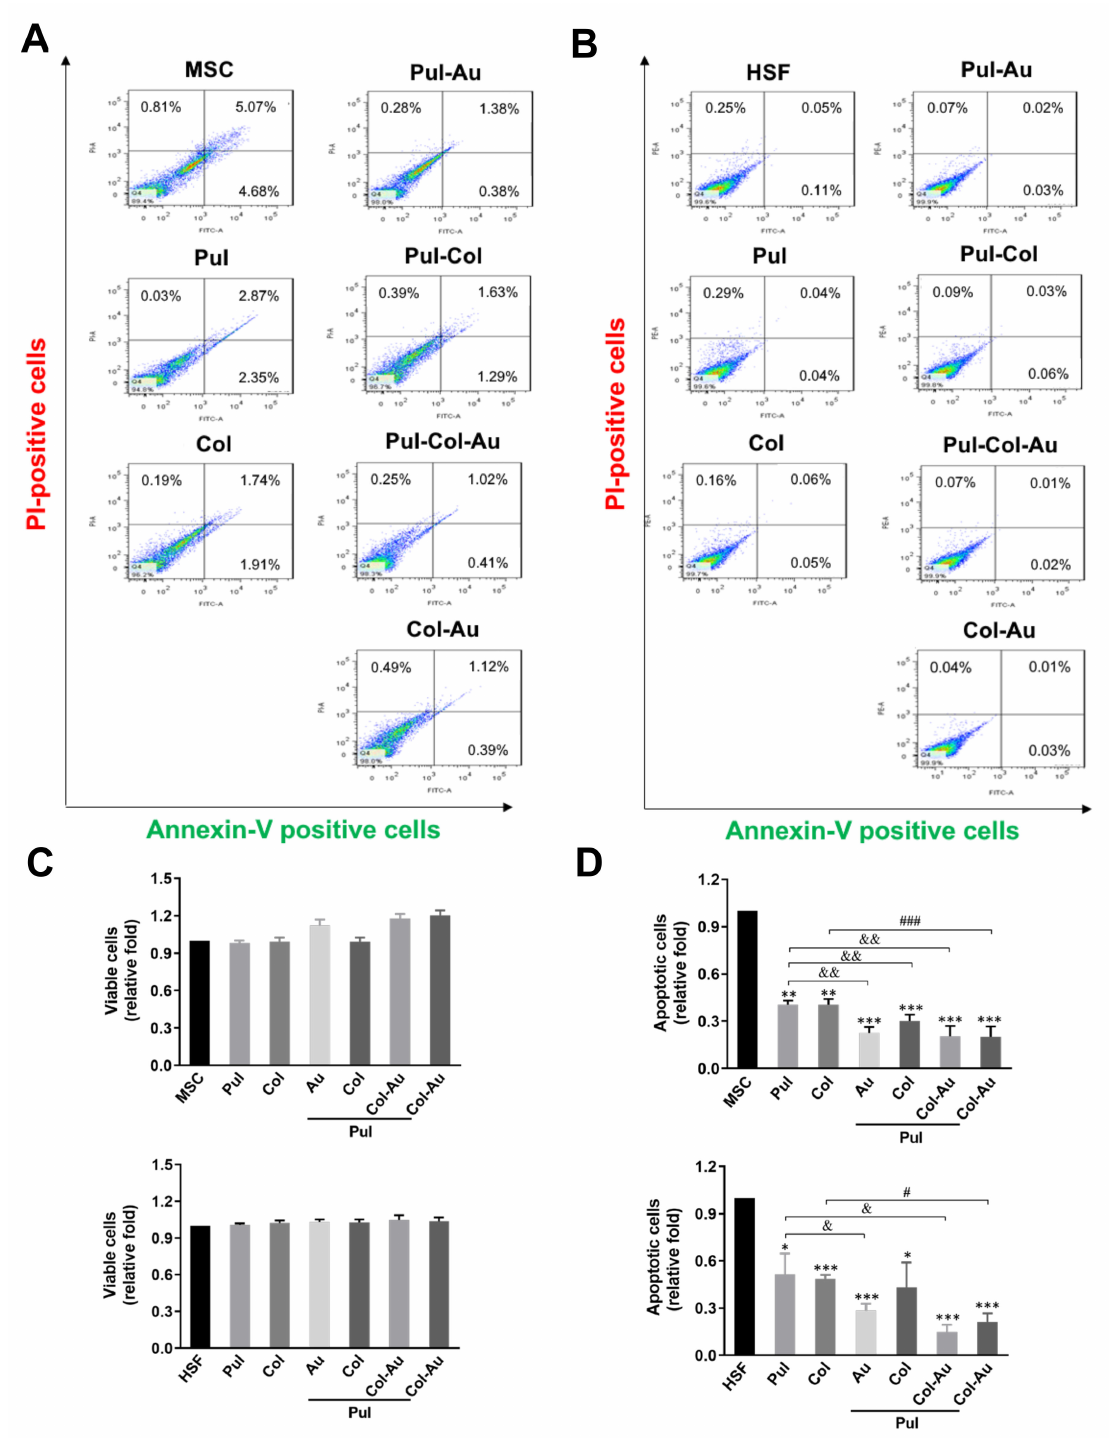
Figure 5. Apoptotic cells induced by various nanomaterials. Annexin V-PI double staining of ( A ) MSCs and ( B ) HSFs was investigated by flow cytometry at 24 h. ( C ) The quantitative results of the viable cells indicate there was no significant difference in the treated groups compared to the control for both cell types. ( D ) The quantitative data of the apoptotic cells demonstrated that the lowest amount was induced by the Pul–Col–Au group compared to the control for MSCs (~0.2-fold) and HSFs (~0.14-fold). Data are displayed as mean ± SD of the three independent experiments. * p < 0.05, ** p < 0.01, *** p < 0.001: compared to MSC or HSF alone group. & p < 0.05, && p < 0.01: compared to Pul group. # p < 0.05, ### p < 0.001: compared to Col